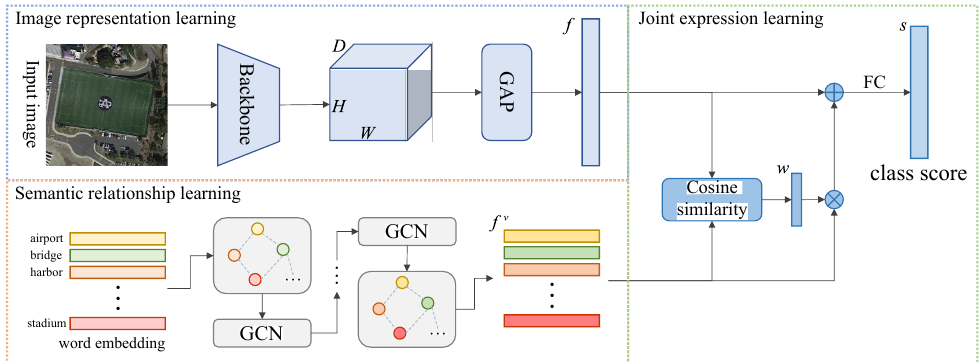
Figure 2. Scene classification on remote sensing images based on label semantic relation learning (LSRL)